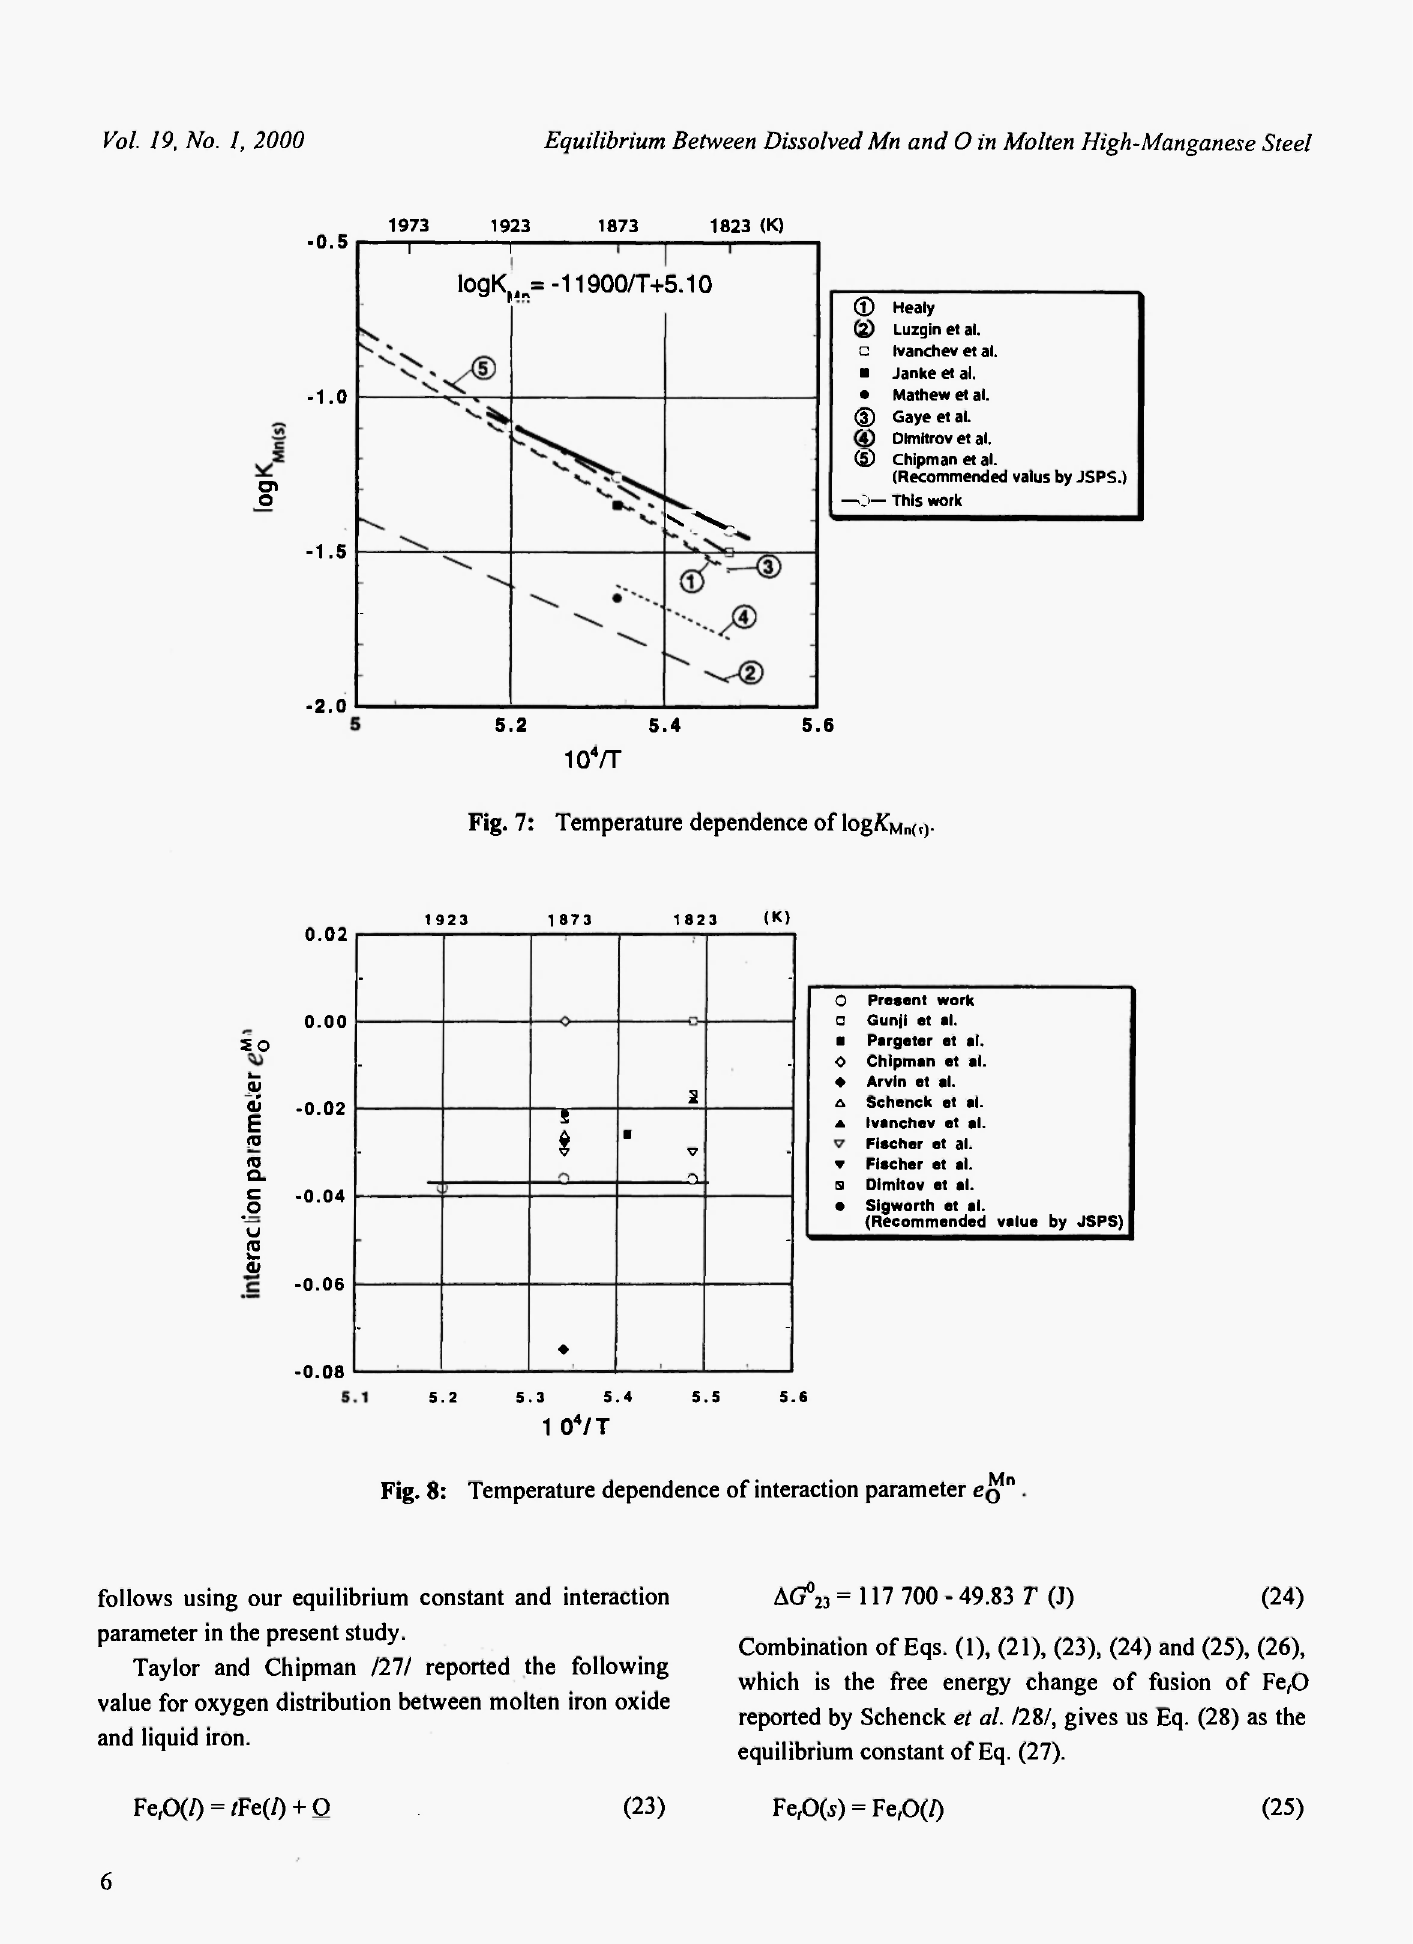
Fig. 8: Temperature dependence of interaction parameter e 0